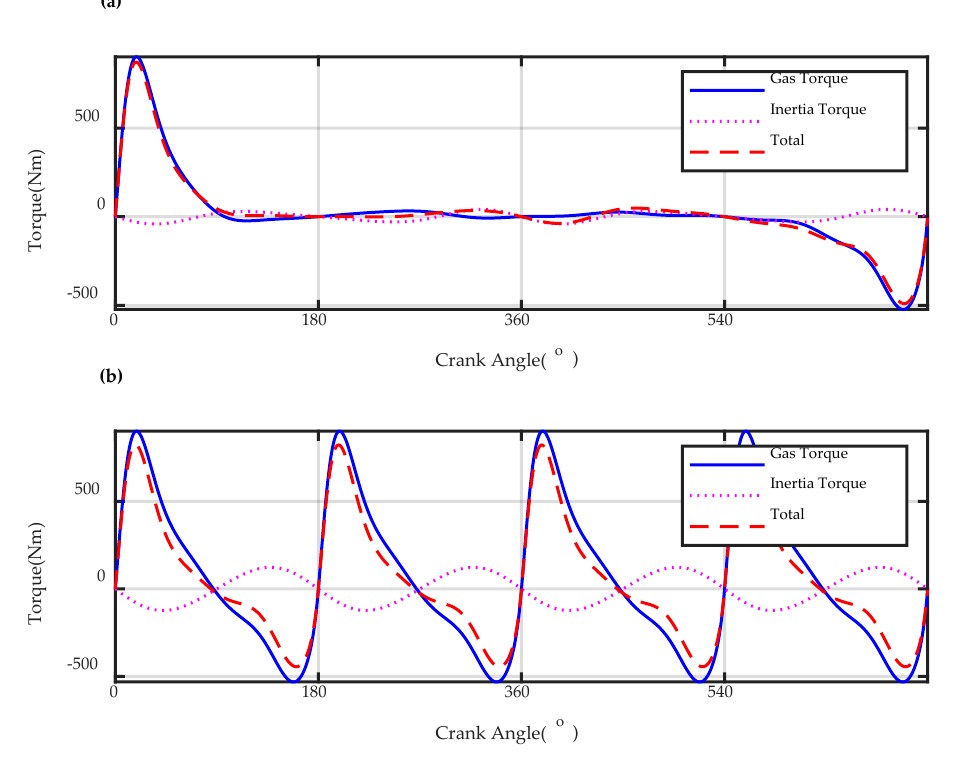
Figure 6. Torques on the crankshaft: ( a ) first cylinder; ( b ) four